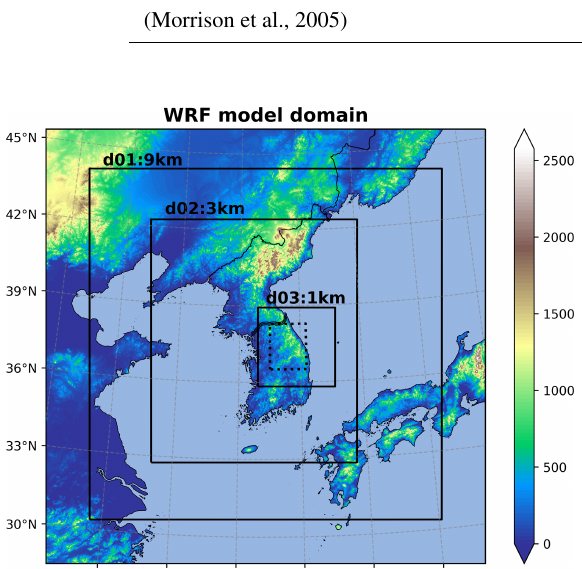
Figure 4. Model domain consisting of the three nested domains with 9, 3, and 1km resolutions centered on the Korean Peninsula. Shading indicates the terrain height (m) above the sea level, and latitudes and longitudes are denoted in the margins. The analysis domain is denoted with a dotted square inside of the innermost do- main